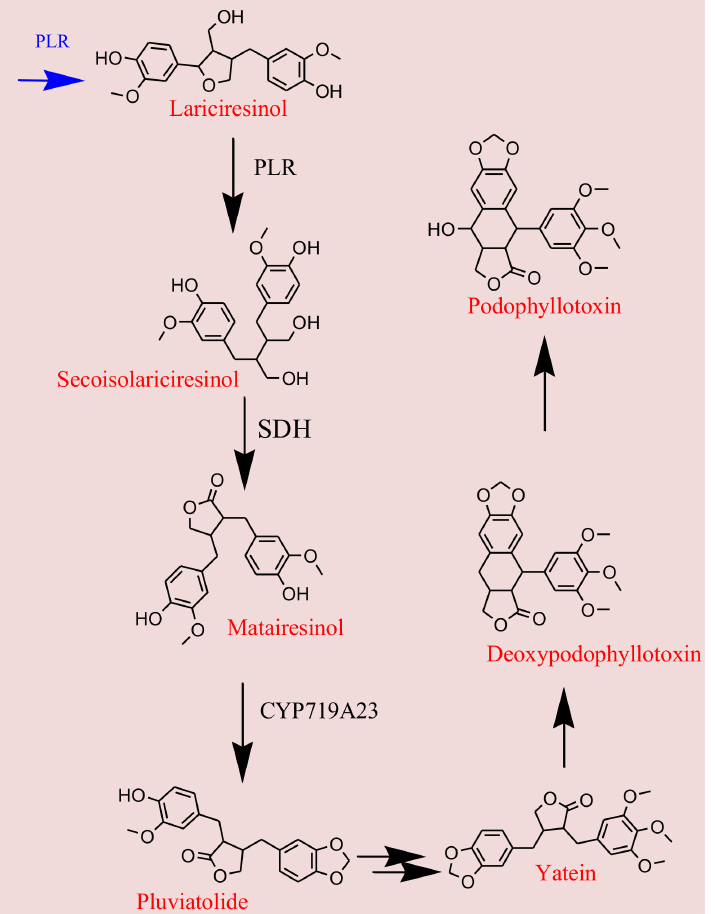
Figure 8. The production of podophyllotoxin in plants takes place in 33 steps where coniferyl alcohol acts as the precursor. The pathway is called phenylpropanoid pathway. In the early steps of podophyllotoxin biosynthesis coniferyl alcohol in formed in nine steps from phenylalanine. Coniferyl alcohol then undergoes a site-selective and unusual enantio-dimerization to form (+)-pinoresinol. Pinoresinol is then reduced to ( − )-secoisolariciresinol, which is catalyzed by a dehydrogenase to ( − )-matairesinol. The next intermediate formed is ( − )-pluviatolide, which is methylated to ( − )-5 (cid:48) - desmethoxy-yatein that is converted to the yatein. Yatein is the intermediate that gets converted to the end product; podophyllotoxin